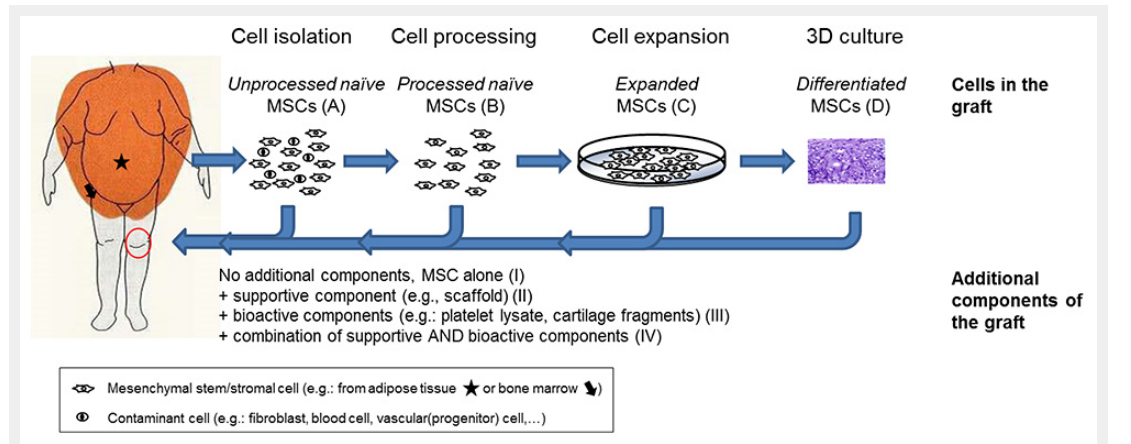
Classification of mesenchymal stromal/stem cell (MSC)-based strategies based on the type and differentiation stage of cells (capital letters in parenthesis) and additional components (Roman numbers in parenthesis) present in the graft. Below are listed examples of MSC-based graft material used in selected clinical trials registered at http://clinicaltrials.gov (keywords used for the research: stem cells AND cartilage repair). A–II: bone marrow MSC aspirate in a scaffold (identifier NCT00885729). B–III: MSCs isolated from adipose tissue specimens (liposuction) combined with platelet-rich plasma (identifier NCT01739504). B–IV: concentrated bone marrow-derived cells on a collagen scaffold, covered with a platelet gel (identifier NCT02005861); MSCs separated from redundant joint tissues (bone marrow or synovium) combined with cartilage fragments in a fibrin gel (identifier NCT01301664). C–I: expanded adipose tissue-derived MSCs alone (identifier NCT01399749). C–III: expanded bone marrow MSCs combined with platelet lysate (identifier NCT02118519). C–IV: expanded bone marrow MSCs combined with chondrocytes in a fibrin gel (identifier NCT02037204). D–II: chondrogenic pellets derived by bone marrow MSCs embedded in a scaffold (identifier